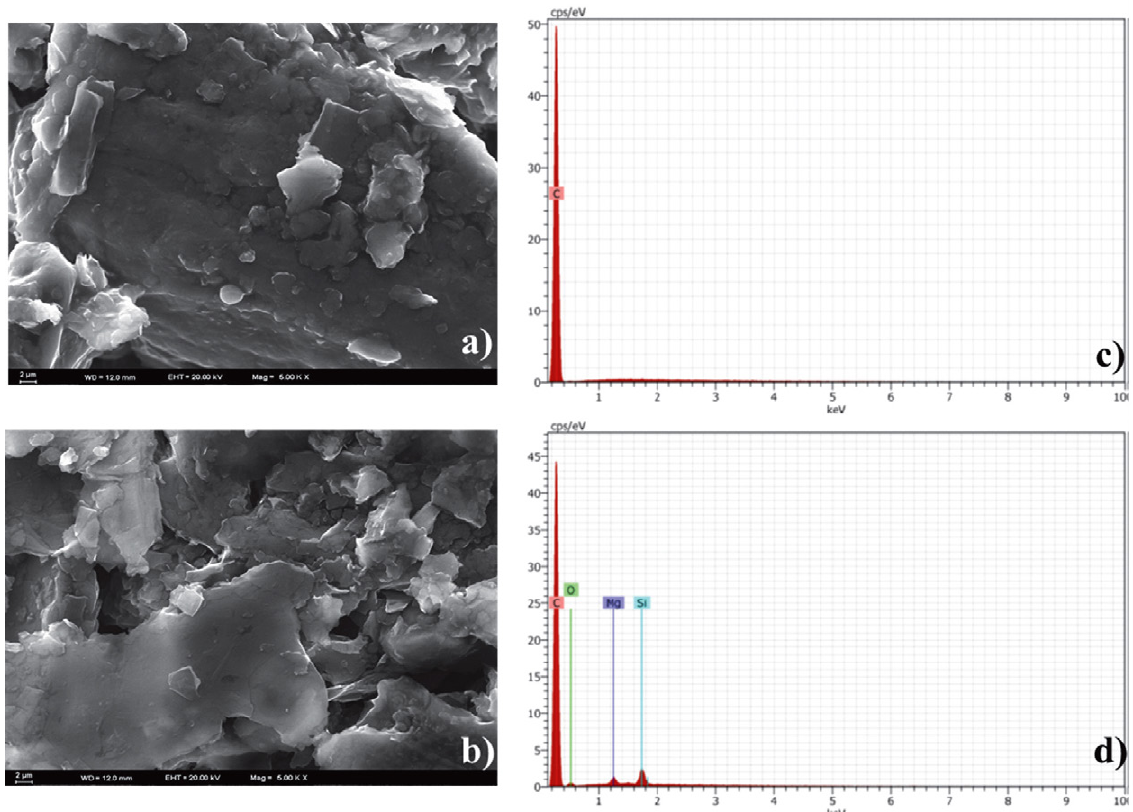
Figure 1. SEM images of CPE (a) and CCPE (b), EDX elemental mapping of CPE (c) and CCPE (d)